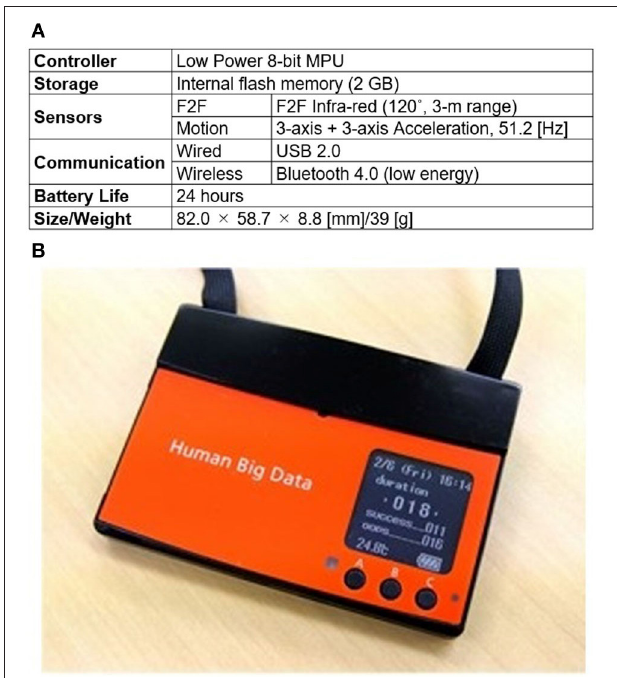
FIGURE 2 | Name-tag shaped wearable sensor node. Nodes continuously measure owner’s body motion and face-to-face communication in workplace without interrupting work. Accelerometer in nodes measures body motion at frequency of 51.2 (Hz). Face-to-face communication is detected by transmitting infrared signals between sensor nodes when they face each other at about three meters. (A) Specifications (B) Appearance This image has been previously published. https://dl.acm.org/doi/fullHtml/10.1145/3358695. 3360923.